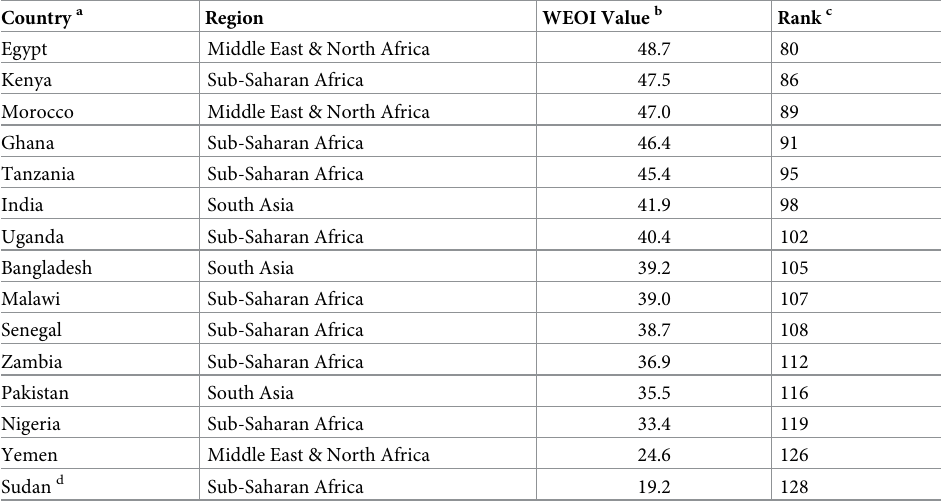
a Classification World Bank for 2012: lower-middle income countries (GNI per capita of maximum US$4,085), except for Malawi Tanzania, Uganda (low income countries, GNI per capita of US$1,035 or less) b Maximum WEOI value: 100.0